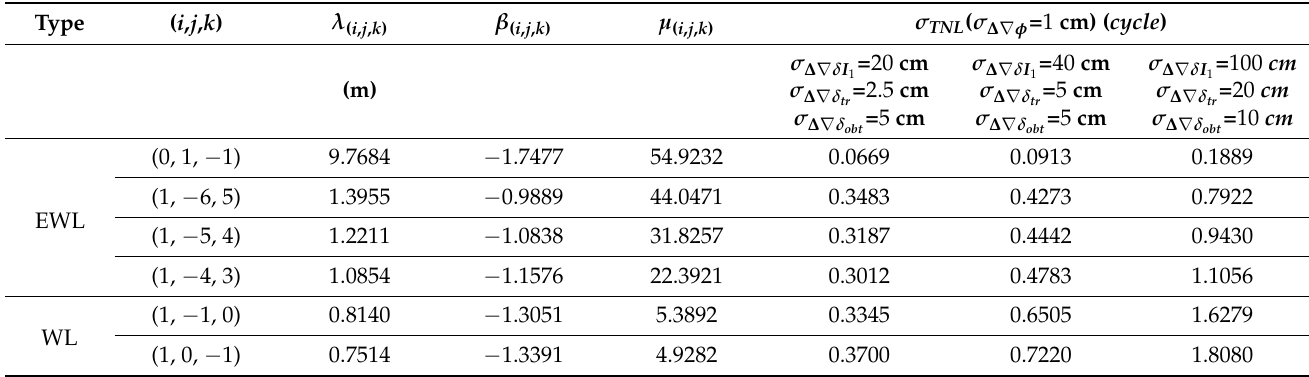
Table 1. Characteristics of some useful extra-wide-lane/wide-lane (EWL/WL) combinations for Galileo signals under three error budget